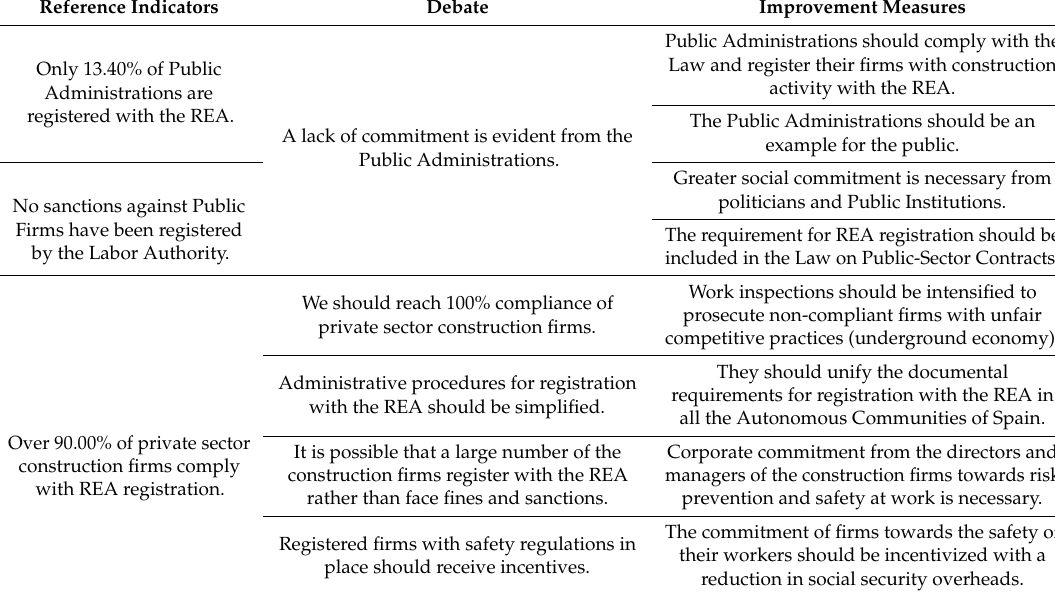
Table 8. Focus Group 2: Entrepreneurs. Conclusions on registration with the REA among Public Administrations and among private sector firms, complemented by improvement